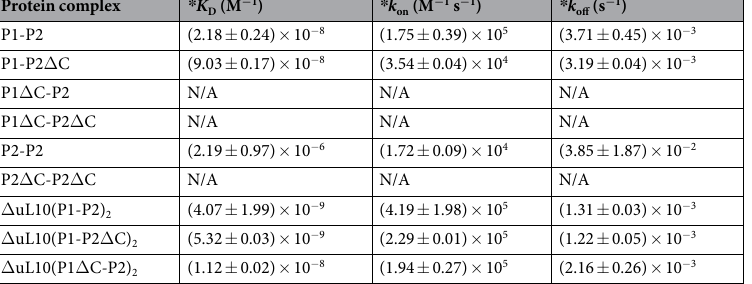
Table 2. Kinetic parameters of the interaction of RTA with human stalk complexes analyzed by bio-layer Interferometry. * K D , k on and k off values represent the average of three replicate